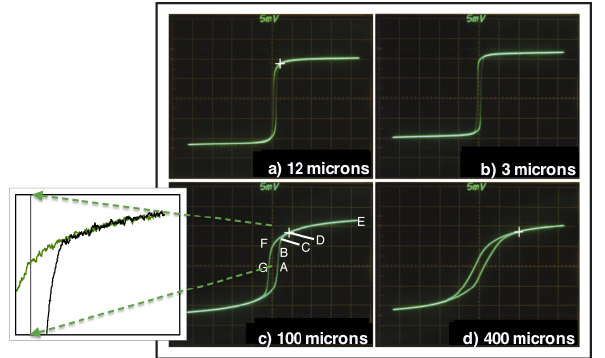
Figure 11. Top panels: Infinetics 12 and 3µm B − H curves. Bot- tom panels: 6–81 100 and 400µm. The drive field is ± 110Am − 1 , a triangle waveform at 25Hz to approximate DC behavior. The in- set for (c) presents a digitally acquired detail of the distinct transi- tion from irreversible behavior to reversible behavior. The argument presented here is that there are no Barkhausen-jump-related losses above the transition point, and that the large variation in B above the transition point requires reversible domain wall motion in the form of channel domain